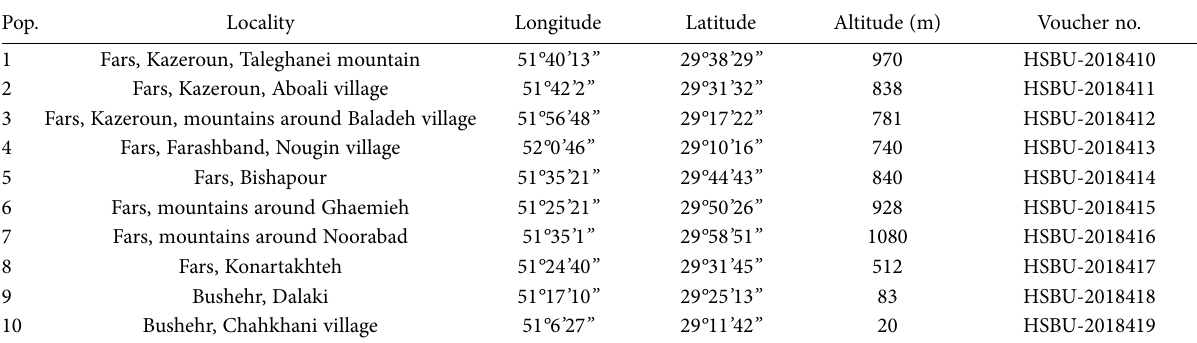
Table 1. The studied populations, their localities and voucher numbers.